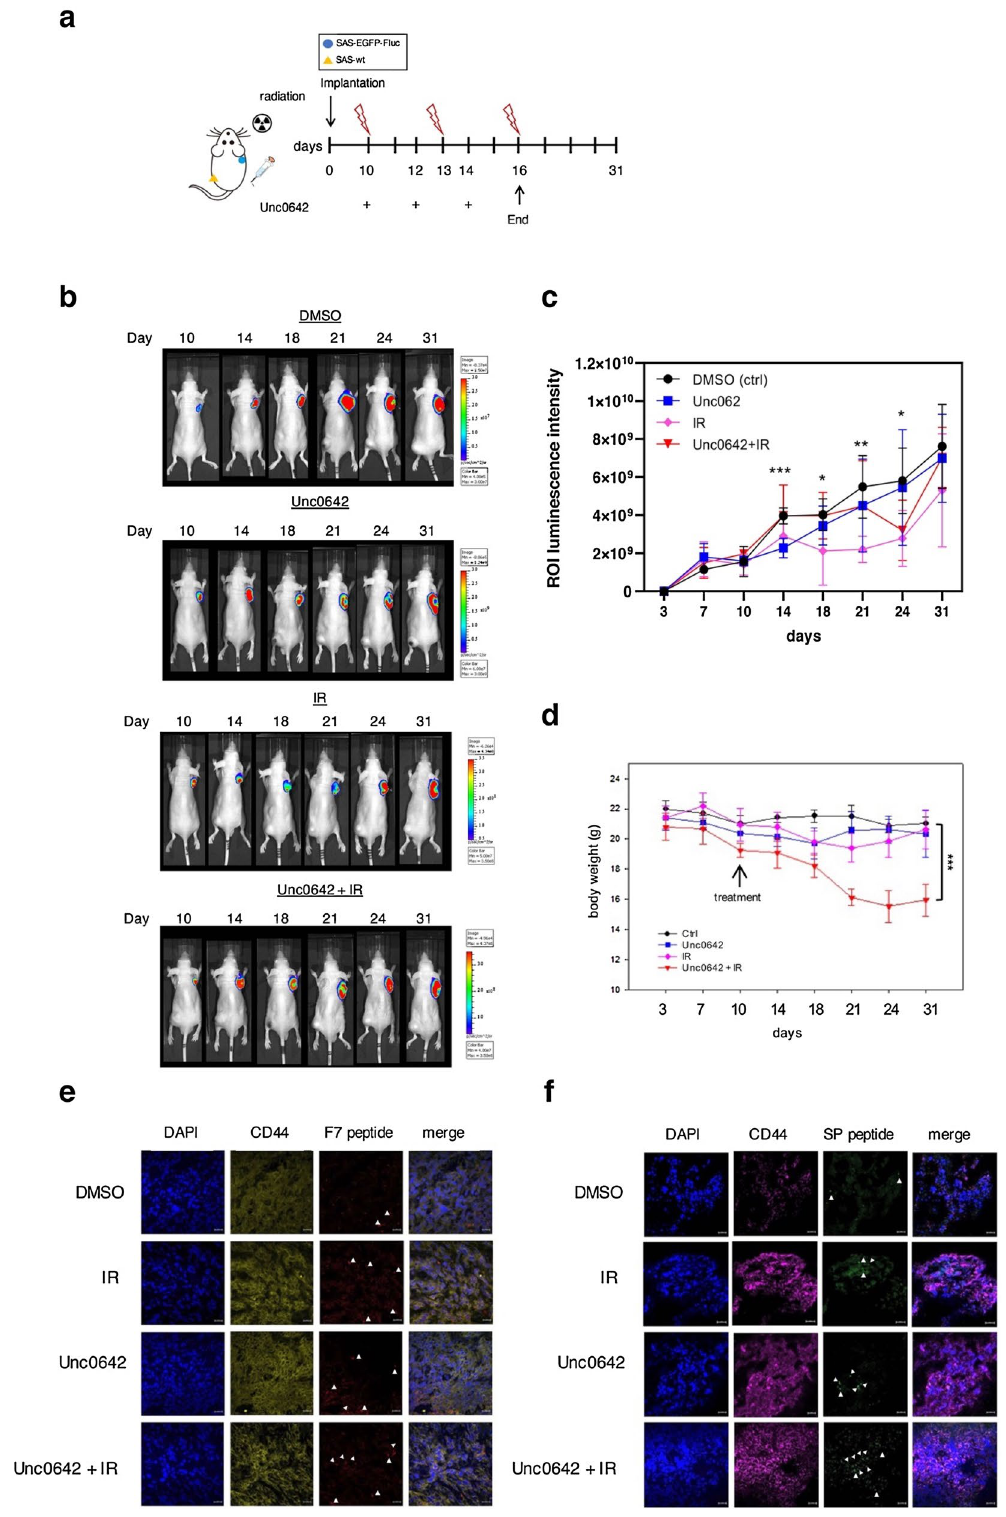
Figure 5. Evaluation of peptide binding ability in SAS xenograft mouse model after the treatment of Unc0642/IR. ( a ) Schematic diagram for in vivo EMT induction via the treatment of Unc0642 and radiation. ( b ) Evaluation of the effect of Unc0642/IR in SAS-EGFP-Fluc-bearing mice by optical bioluminescence image. ( c ) Tumor burden of each group was monitored at indicated time points. Data represent mean ± SD (n = 5–6/group). * p < 0.05, ** p < 0.01, *** p < 0.001 by Student’s t -test. *** p = 0.00058, Ctrl versus Unc0642 on day 14; * p = 0.049, Ctrl versus IR on day 18; ** p = 0.0023, Ctrl versus IR on day 21; * p = 0.0179, Ctrl versus IR on day 24; * p = 0.036, Ctrl versus Unc0642 + IR on day 24. ( d ) The body weights of mice were recorded during the period of monitoring. Data are mean ± SD (n = 5–6/group). ( e , f ) Mice were given an intra- tumoral injection of peptide. At 24 h later, tumor samples were excised and the signal derived from the peptide was observed using confocal microscopy. Representative confocal micrographs of tissue sections immunolabeled with CD44. The arrowheads indicate the presence of F7 and SP peptide. Blue: DAPI. Scale bar, 20